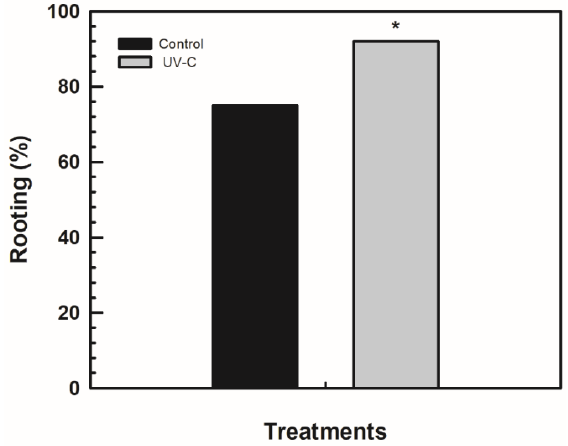
Figure 5. Rooting percentage (%) ( n = 30) of P. × hortorum stem cuttings irradiated with 1 kJ m − 2 or left nonirradiated (controls) over a 6-week period. Asterisk indicates the significant difference between treatment means at p = 0.05.